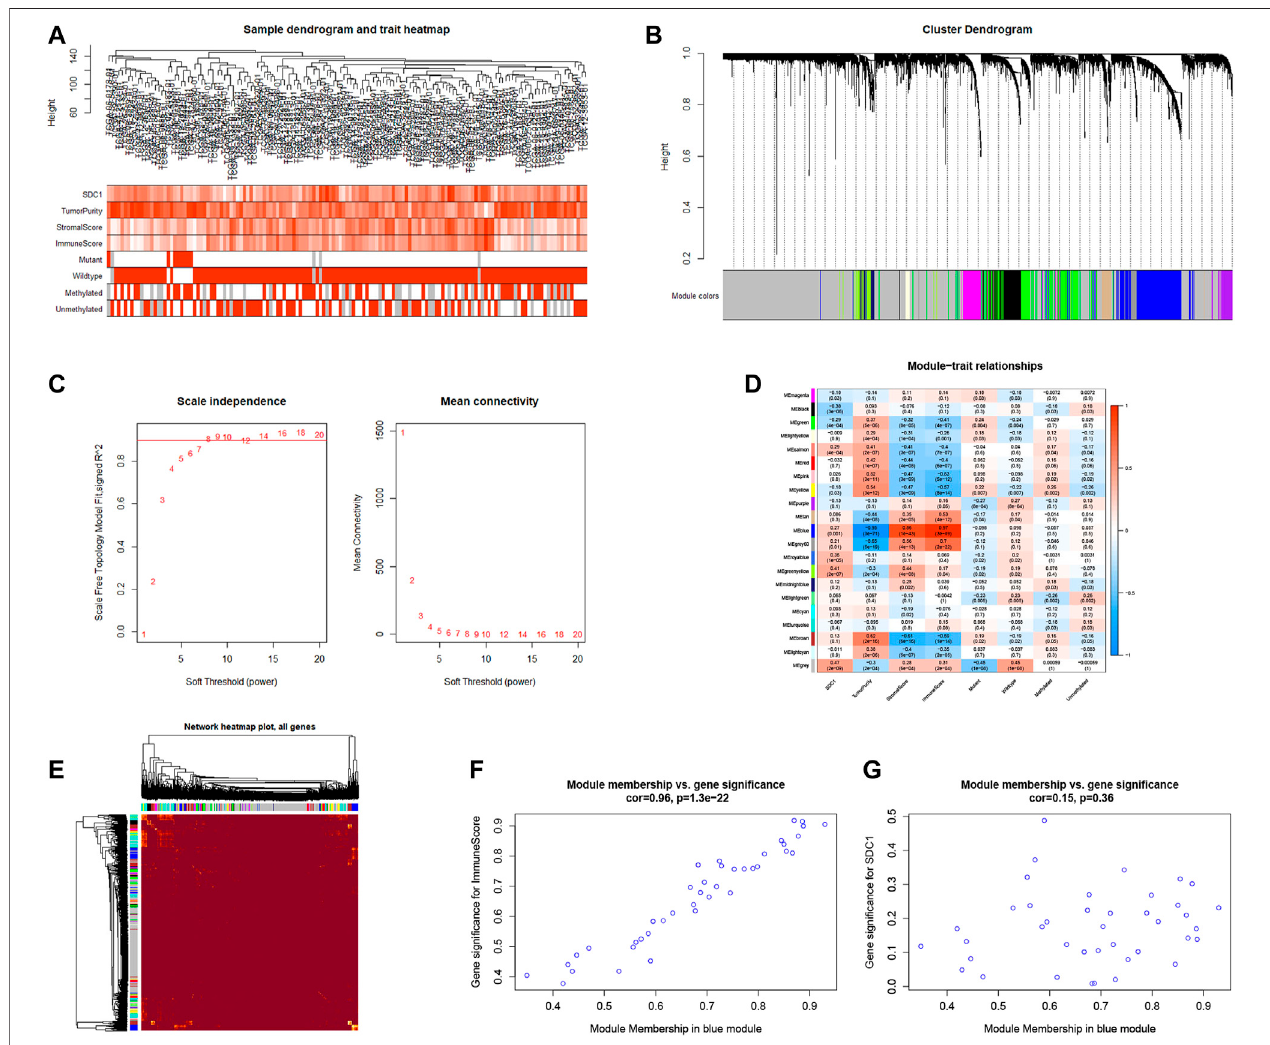
FIGURE5| TheWGCNAmethodwasusedto fi ndthegenesthatarenotonlyrelatedtoSDC1butalsoinvolvedingliomaimmunein fi ltration. (A) Mappingofclinical traitvariables and aggregation treesshow thelandscape oftheexpression ofSDC1, immune score,and clinicalphenotype. (B) The dynamic tree display differentcolor- coded co-expression modules were constructed. (C) The soft thresholding and correlation coef fi cient in the scale-free topology fi tting graph. (D) Correlation between module eigengenes and clinical traits. The clinical traits include the expression of SDC1 and immune score. The corresponding correlations and p -values are presented. (E) A TOM plot showed that each module in the network was independent of each others, further indicating that gene expression in each module was also relatively independent. (E,F) The blue module was identi fi ed to have the highest positive correlation with the expression of SDC1 and immune score.